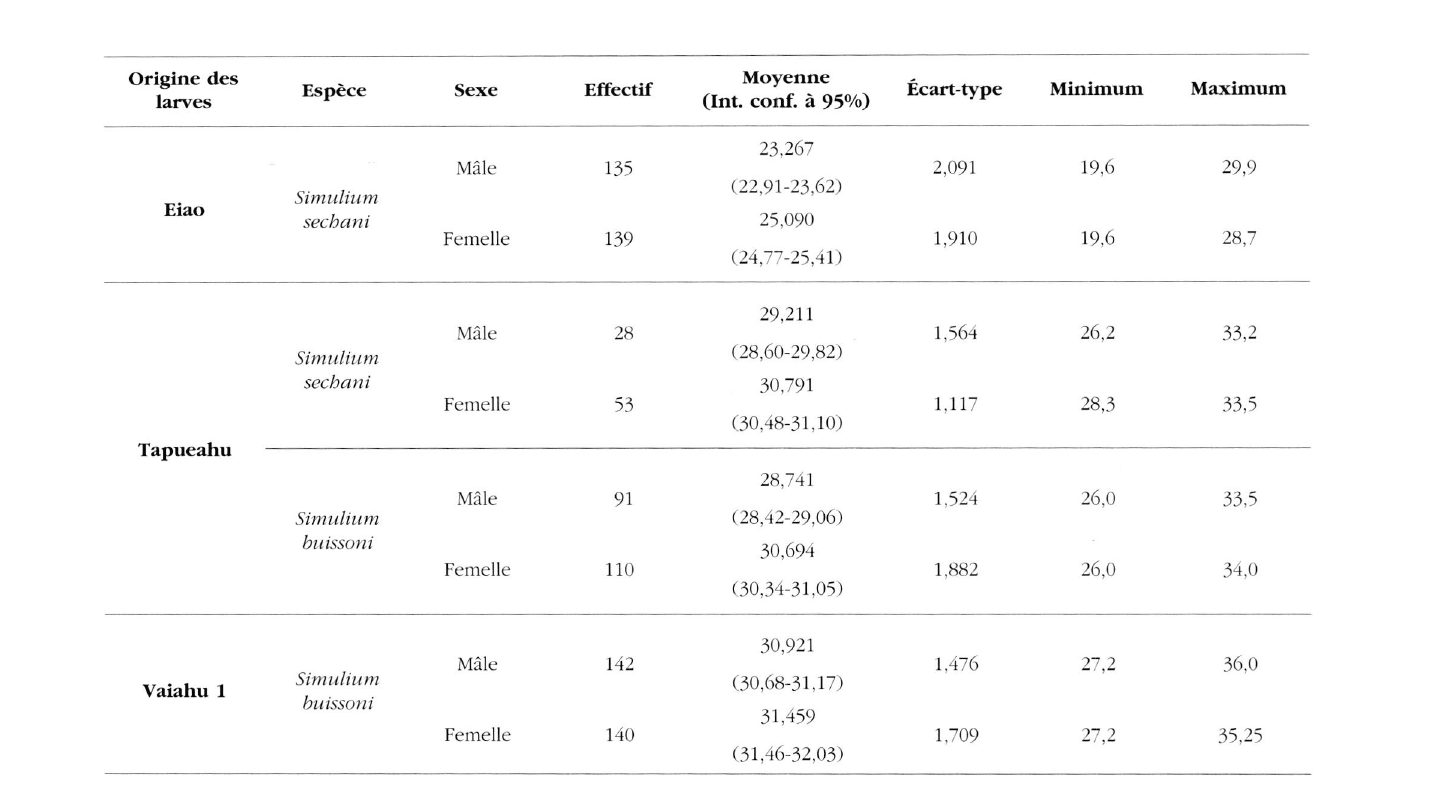
Tableau IV. - Caractéristiques du paramètre "a" des stades VI de S. sechani et S. buissoni. Les mesures de taille correspondent à des lec tures directes au micromètre oculaire et n'ont pas été converties en unités standardisées.